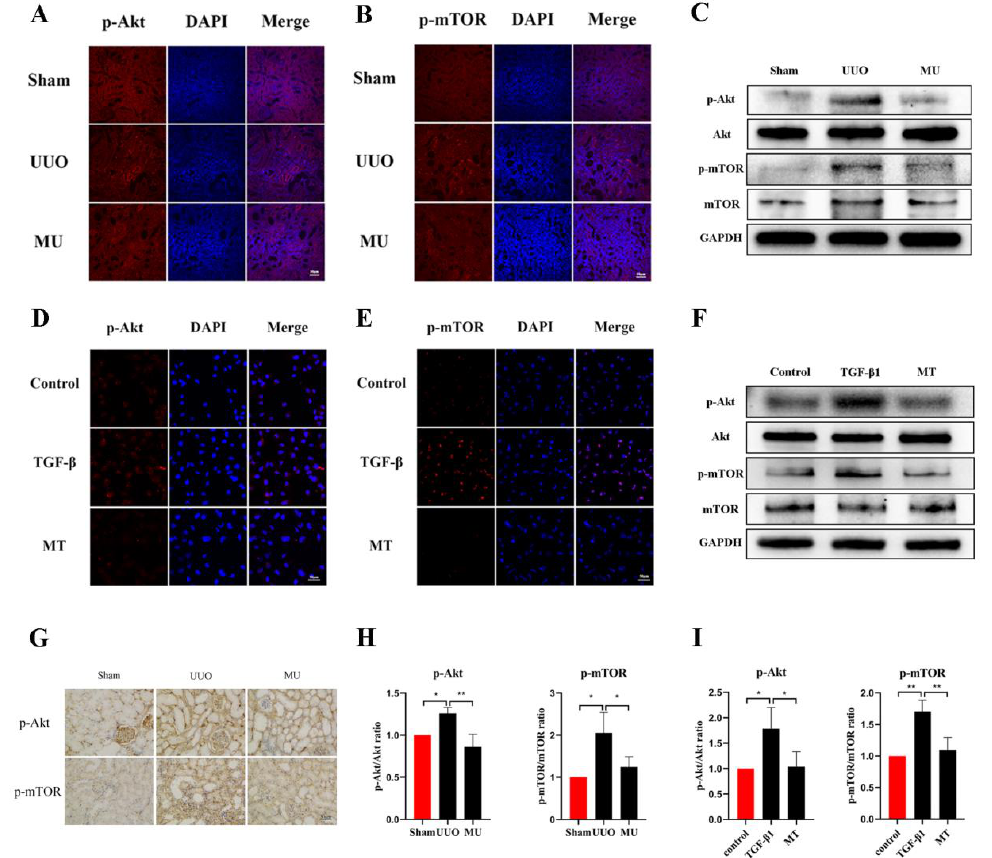
Figure 6. MK-2206 inhibited the activation of the Akt/mTOR signaling pathway in vivo and in vitro. ( A , B ) Expression levels of p-Akt and p-mTOR in the kidneys of each group of mice were detected by immunofluorescence staining (scale bar: 50 μm). ( C , H ) Protein expression levels of p-Akt and p-mTOR in vivo were detected by Western blot. ( D , E ) Expression levels of p-Akt and p-mTOR in HK-2 cells were detected by immunofluorescence staining (scale bar: 50 μm). ( F , I ) Western blot was used to detect the protein expression levels of p-Akt and p-mTOR in vitro. ( G ) Immunohistochemical staining of the kidneys in each group of mice using p-Akt and p-mTOR (scale bar: 30 μm). Protein levels were normalized with GADPH. * p < 0.05, ** p < 0.01. MU: UUO + MK-2206, MT: TGF- β 1 + MK-2206.